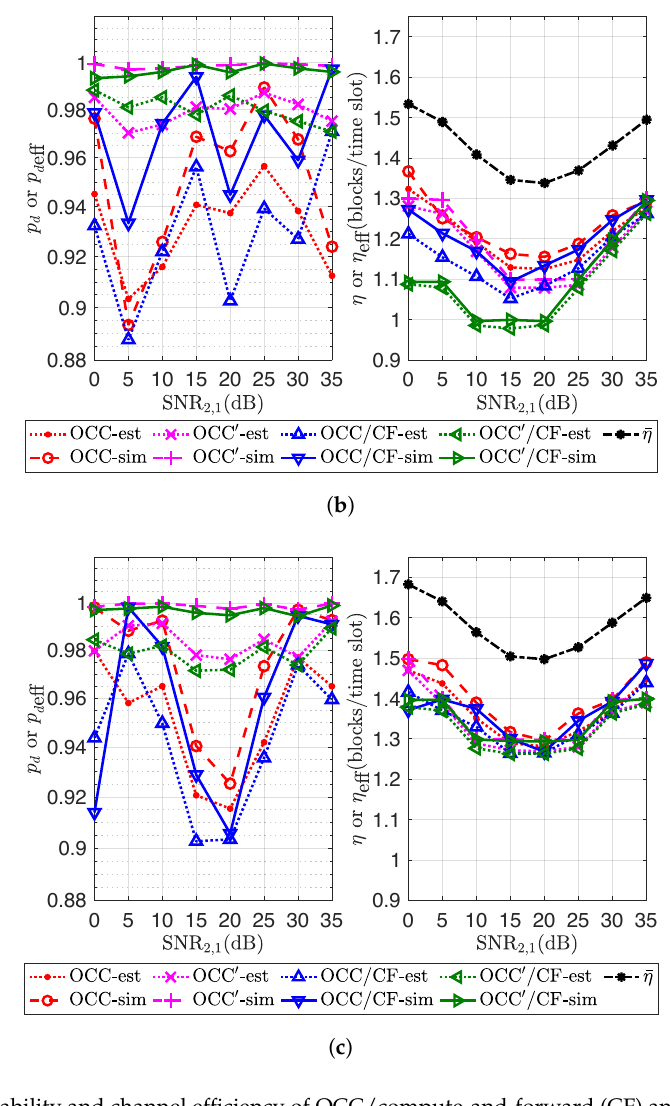
Figure 9. Decodability and channel efficiency of OCC/compute-and-forward (CF) and OCC (cid:48) /CF from estimation and simulation. ( a ) SNR 1,2 = 5 dB; ( b ) SNR 1,2 = 20 dB; ( c ) SNR 1,2 = 35